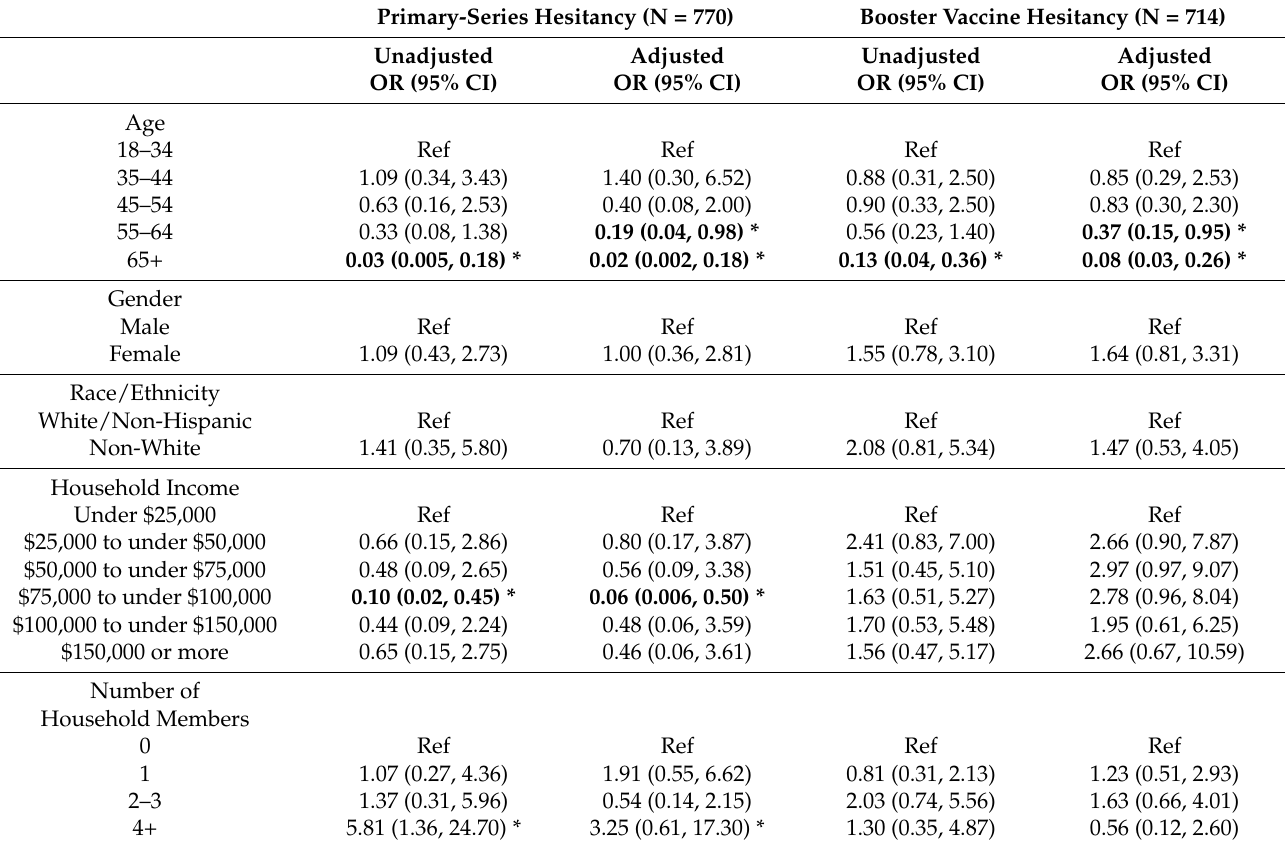
Unadjusted and Adjusted ORs for primary-series vaccine hesitancy and booster vaccine